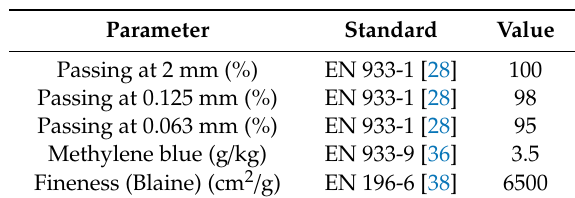
Table 3. Filler characteristics.